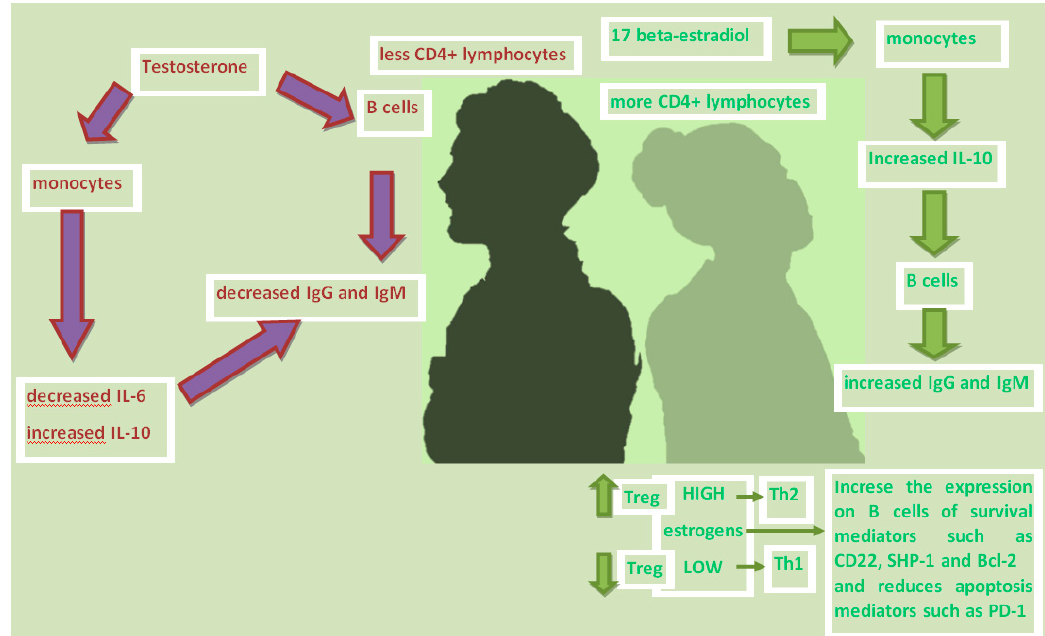
Figure 1. Showing some of the differences between males and females’ immune response. Estrogens increase the production of immunoglobulins mainly by increasing the production by monocytes of IL-10, which in turn triggers the secretion of IgG and IgM by B cells; in contrast, testosterone has been found to reduce immunoglobulin production directly damaging the secretion of IgG and IgM in B lymphocytes, and indirectly by reducing the production of IL-6and increasing IL-10 from monocytes; estrogen increase the expression regulation of B cell survival mediators, such as CD22, SHP-1 and Bcl-2, and change the expression of the PD-1, an apoptosis mediator; T-regulatory cells (T-reg) are sensitive to changes in sex hormone levels during the ovarian cycle: increase with high estrogen levels and decrease with low estrogens and high progesterone; low estrogens means T helper (Th) differentiation towards Th1 while high doses of estrogen towards the Th2 phenotype.